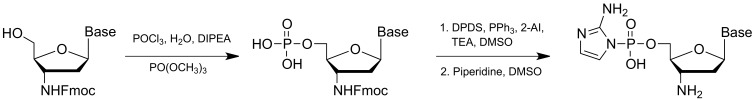
2-AIp2sU synthesis.